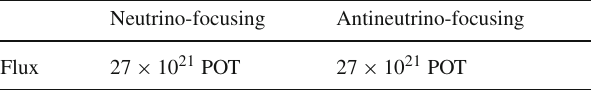
Neutrino-focusing